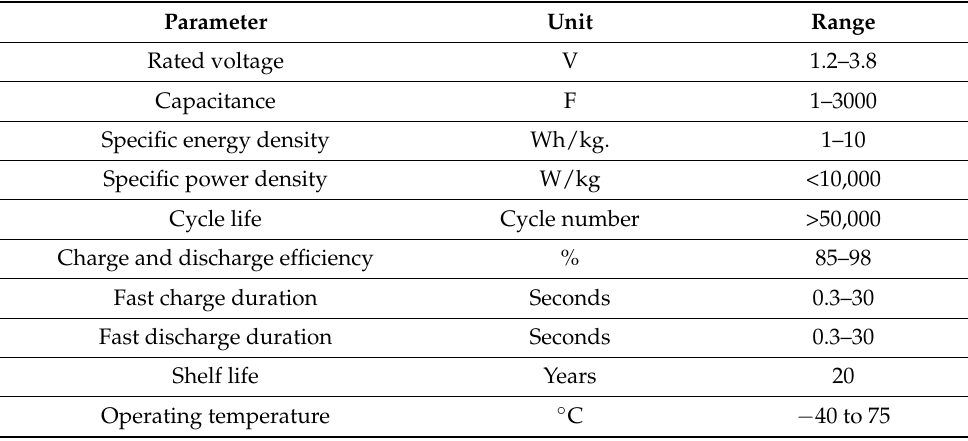
Table 5. Supercapacitor specifications.